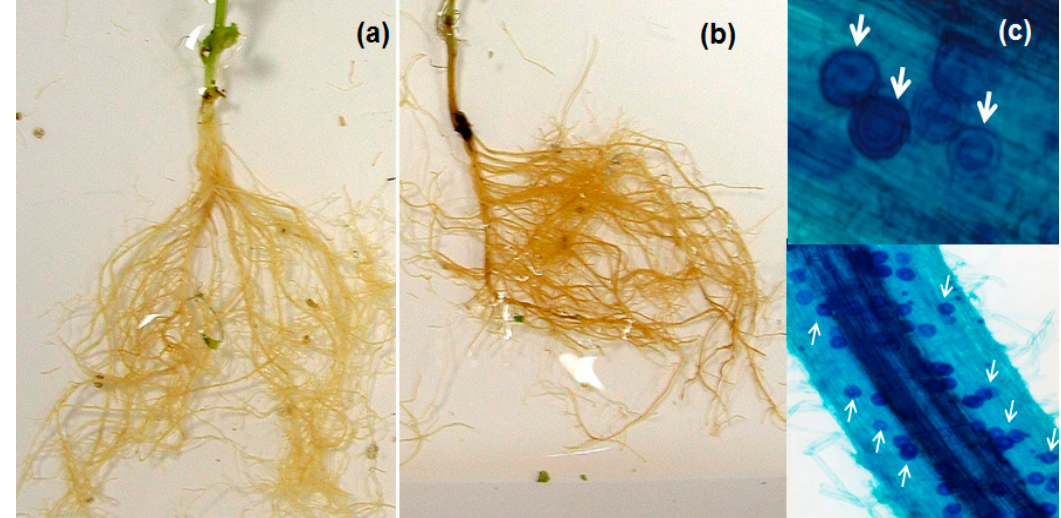
Figure 1. Pea stem basal part and root necrosis at 10 days after inoculation with 10 5 zoospores of Aphanomyces euteiches at 5-weeks-old; ( a ) Roots of plant injected with a solution of nonacetylated oligogalacturonides (OGs − Ac) elicitor in the upper two rachises (20 µg/rachis = 40 µg/plant) at two weeks before inoculation; ( b ) Controls injected with water; ( c ) Plant roots colored with lactophenol cotton blue. A. euteiches oospores indicated with white arrows.